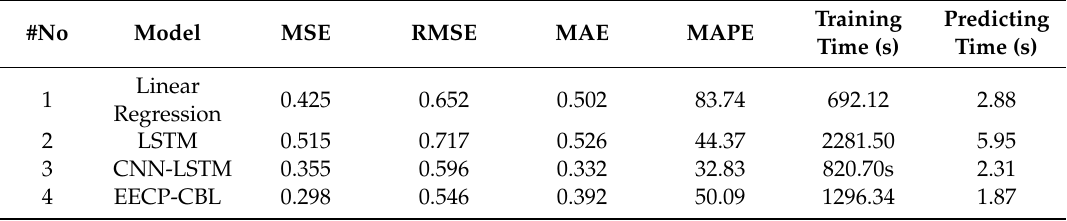
Table 4. Performances of the experimental methods for hourly dataset.